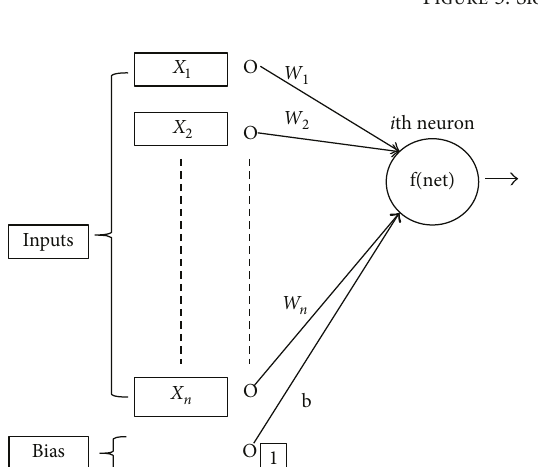
Figure 5: Slopes of an ignored edge.